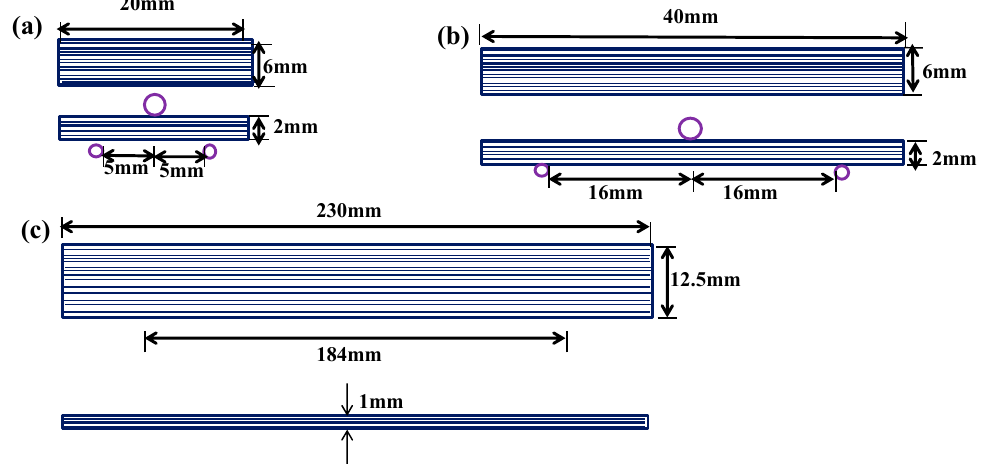
Figure 3. The schematic of ( a ) interlaminar shear strength (ILSS) test specimen, ( b ) flexural test specimen and ( c ) tensile test specimen.